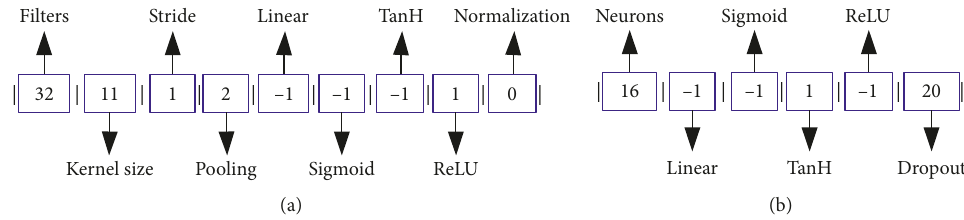
Figure 4: Predictor input examples. In (a), the descriptor CR;32;11;1;2 is represented. In (b), the descriptor FT;16;0.2 is represented.